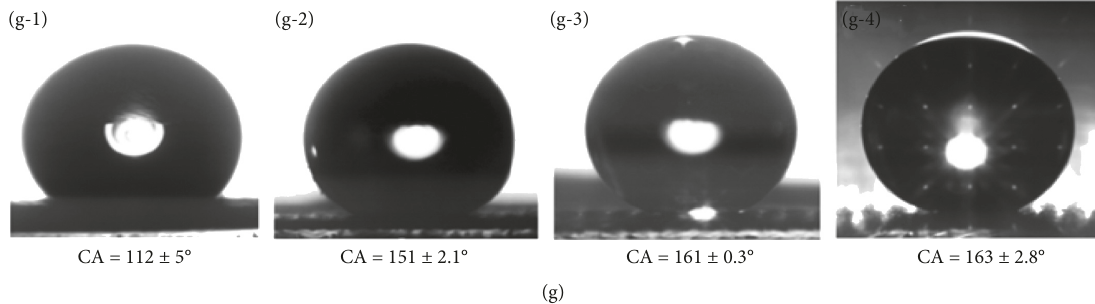
Figure 4: The different wettability of brine and diesel on (a, b) Al alloy and (c, d) stainless steel substrates. The contact angle (CA) image of brine on (e) P-Al, M-Al, N-Al, and MN-Al plates and stainless steel (f) plates and (g) screens, all the samples were modified by STA. The magnification scale was